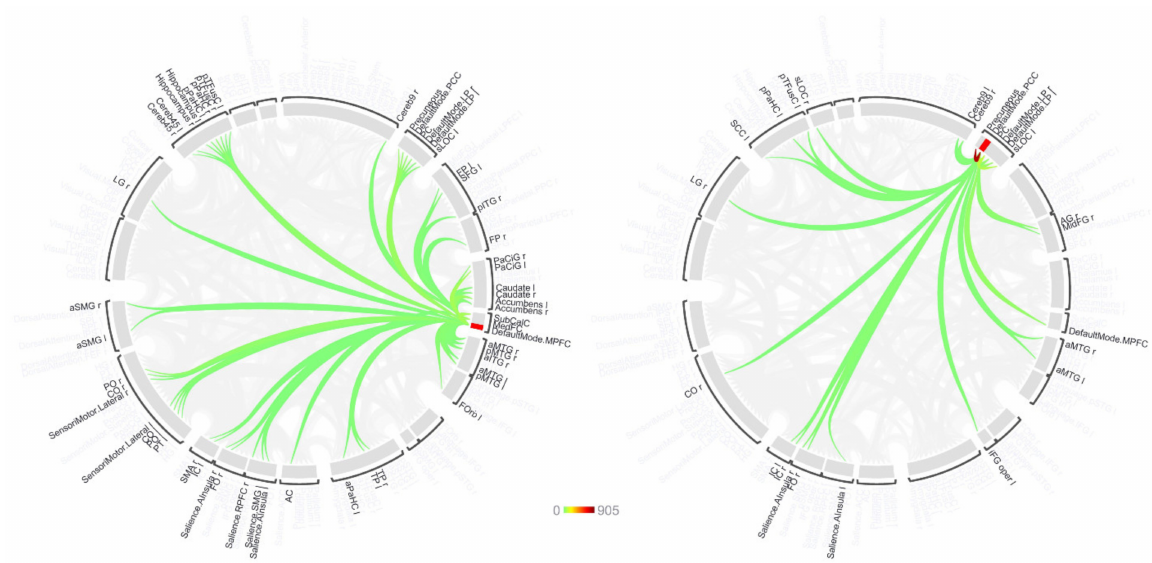
Figure 1. Results of second-level rs-fMRI analysis for seeds in the MPFC and PCC (left and right, respectively) displayed as a connectome ring. Around the ring, 165 brain regions are indicated that were evaluated for connectivity with the seed in the first-level analysis. The coloured traces represent connections that were seen in second-level analysis to be significantly associated with a combination of exercise performance and first principal component of the neuropsychological evaluation results after corrected for multiple comparison (FDR, p < 0.05). The rings were plotted with a common scale (coloured bar) based on the largest F-statistic encountered in this cohort